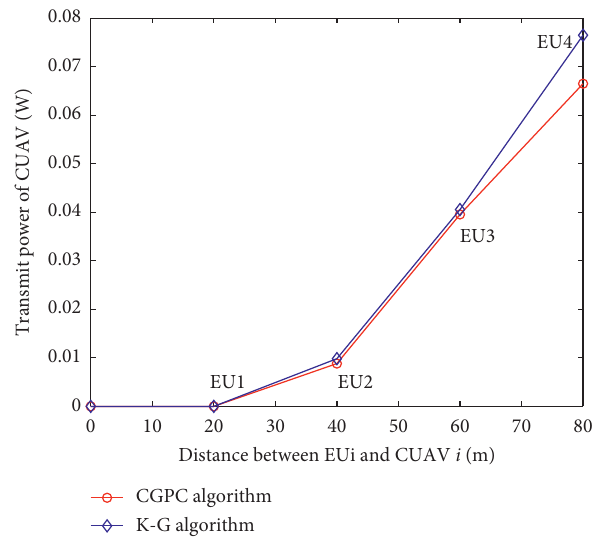
Figure 3: Comparison of cooperative UAV transmitted power under different